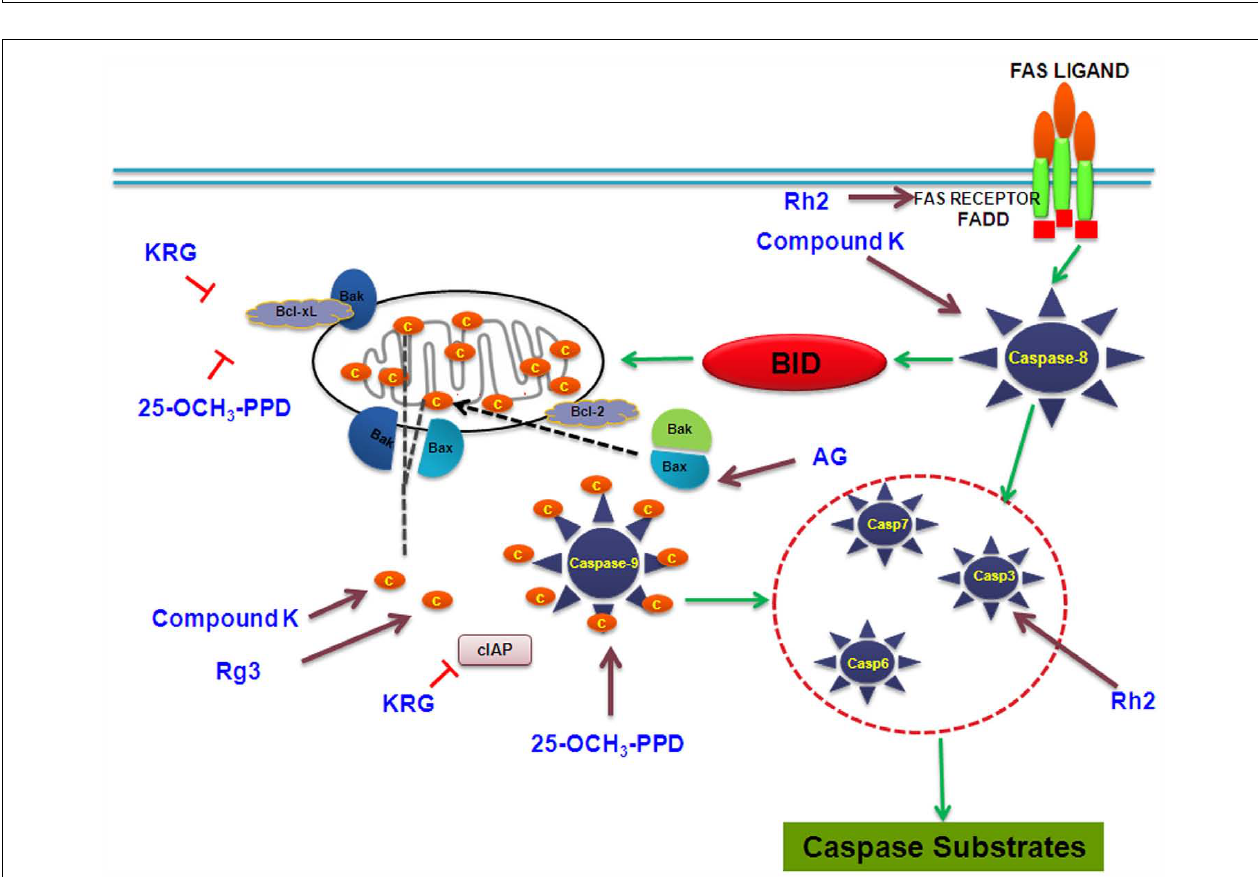
FIGURE 4 | Cell signaling pathways involved in cell cycle arrest targeted by selected ginsenosides. Rb, retinoblastoma protein.